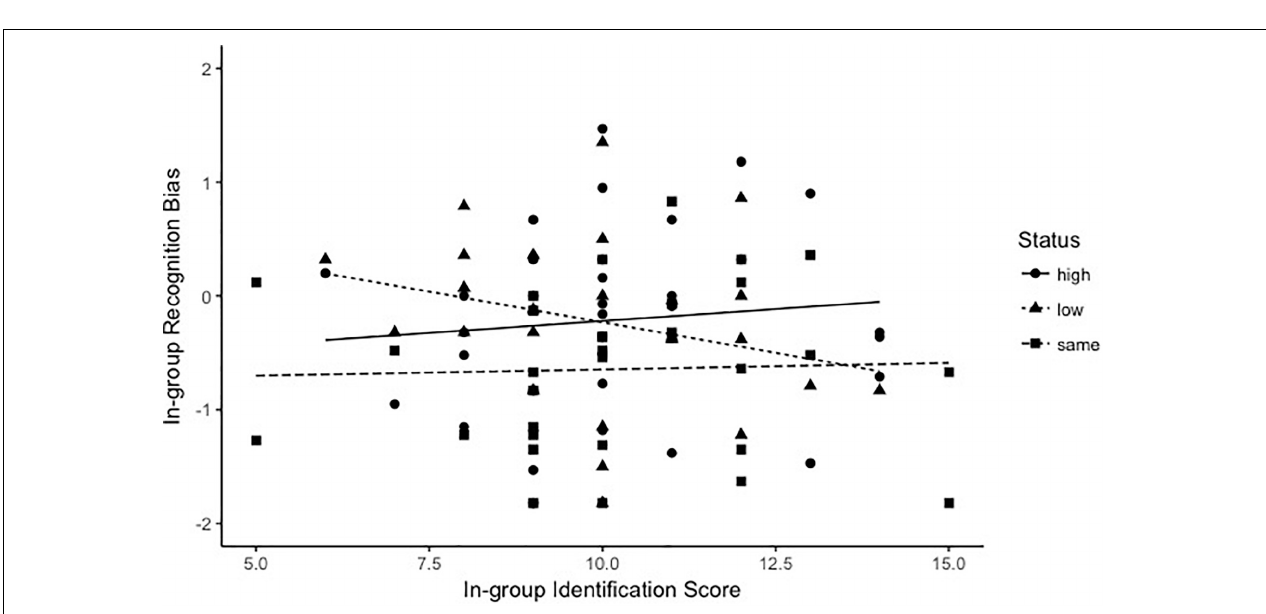
FIGURE 5 | Response bias C for faces assigned to different groups with high, low, or same power. Black bars refer to in-group members, and gray bars refer to out-group members. Error bars represent standard errors (** p < 0.01 and *** p < 0.001).